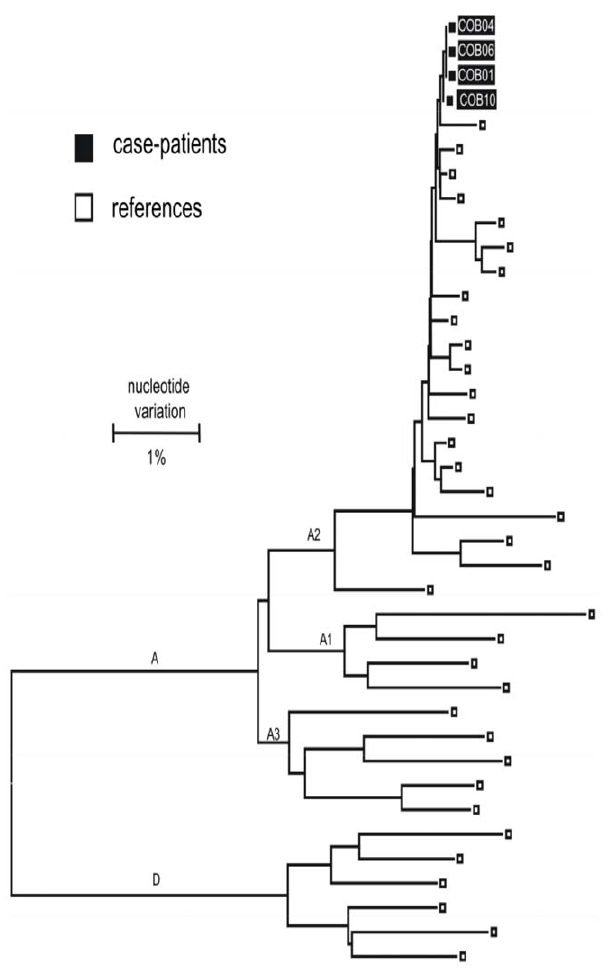
Figure 1. Phylogenetic relationship of the complete HBV genomic sequences of 4 long term care facility (LTCF) A residents with newly diagnosed HBV infection and represen- tative HBV genotype A (n=29) and D (n=6) strains. Represen- tative HBV genotype A and D strains were retrieved from GenBank and CDC’s sequence database. The 4 LTCF A residents are shown by the solid boxes.